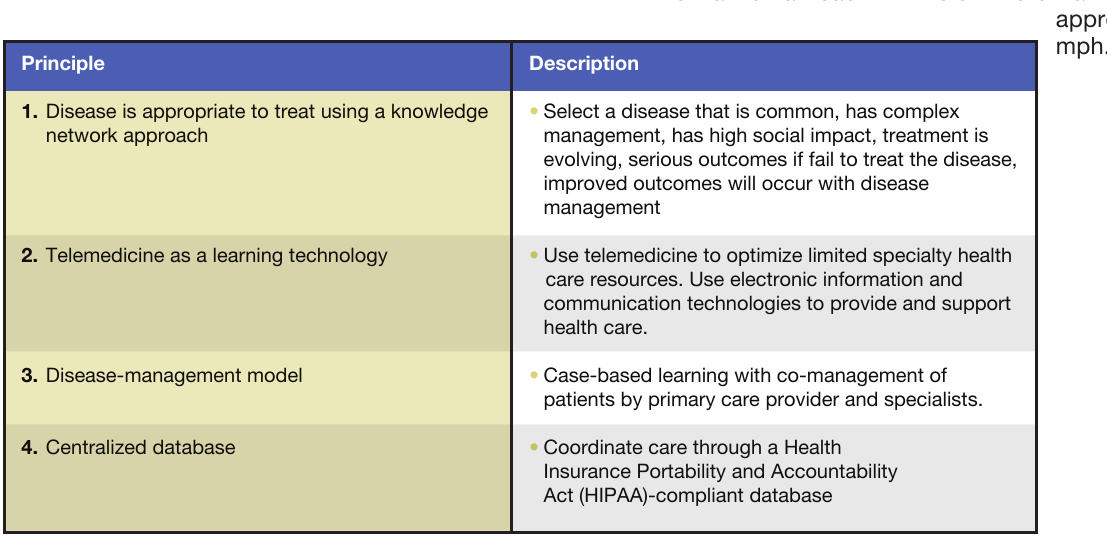
Table 1: Program elements for implementing specialty